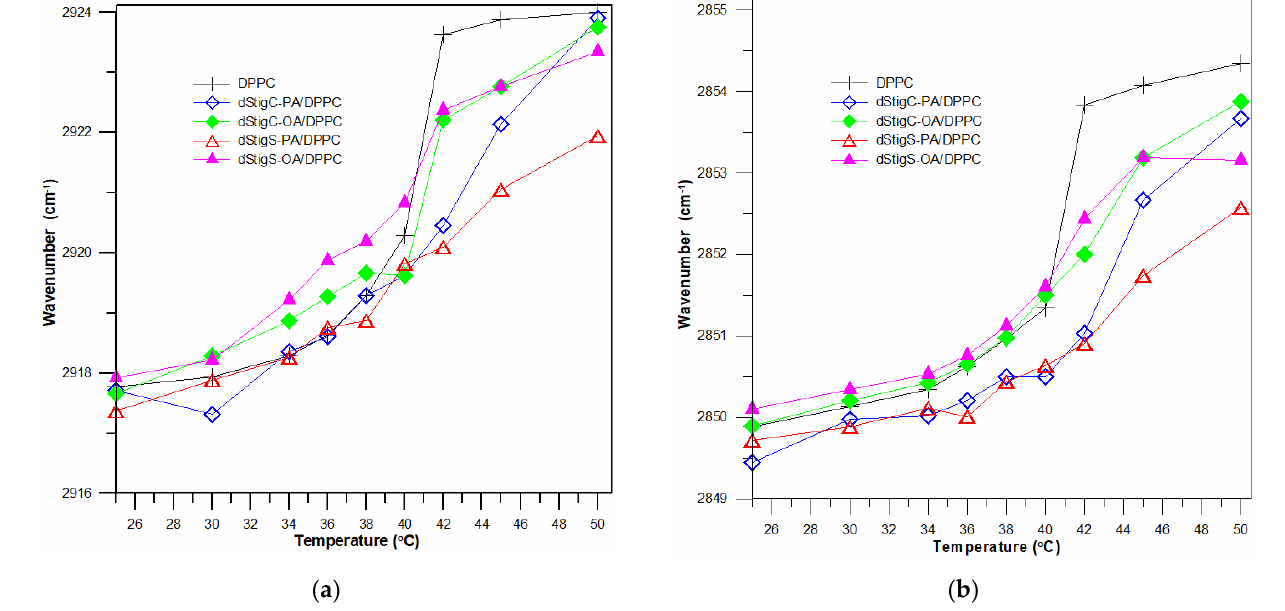
of hydrocarbon chains for DPPC and for the dStigMAs/DPPC system are compared.